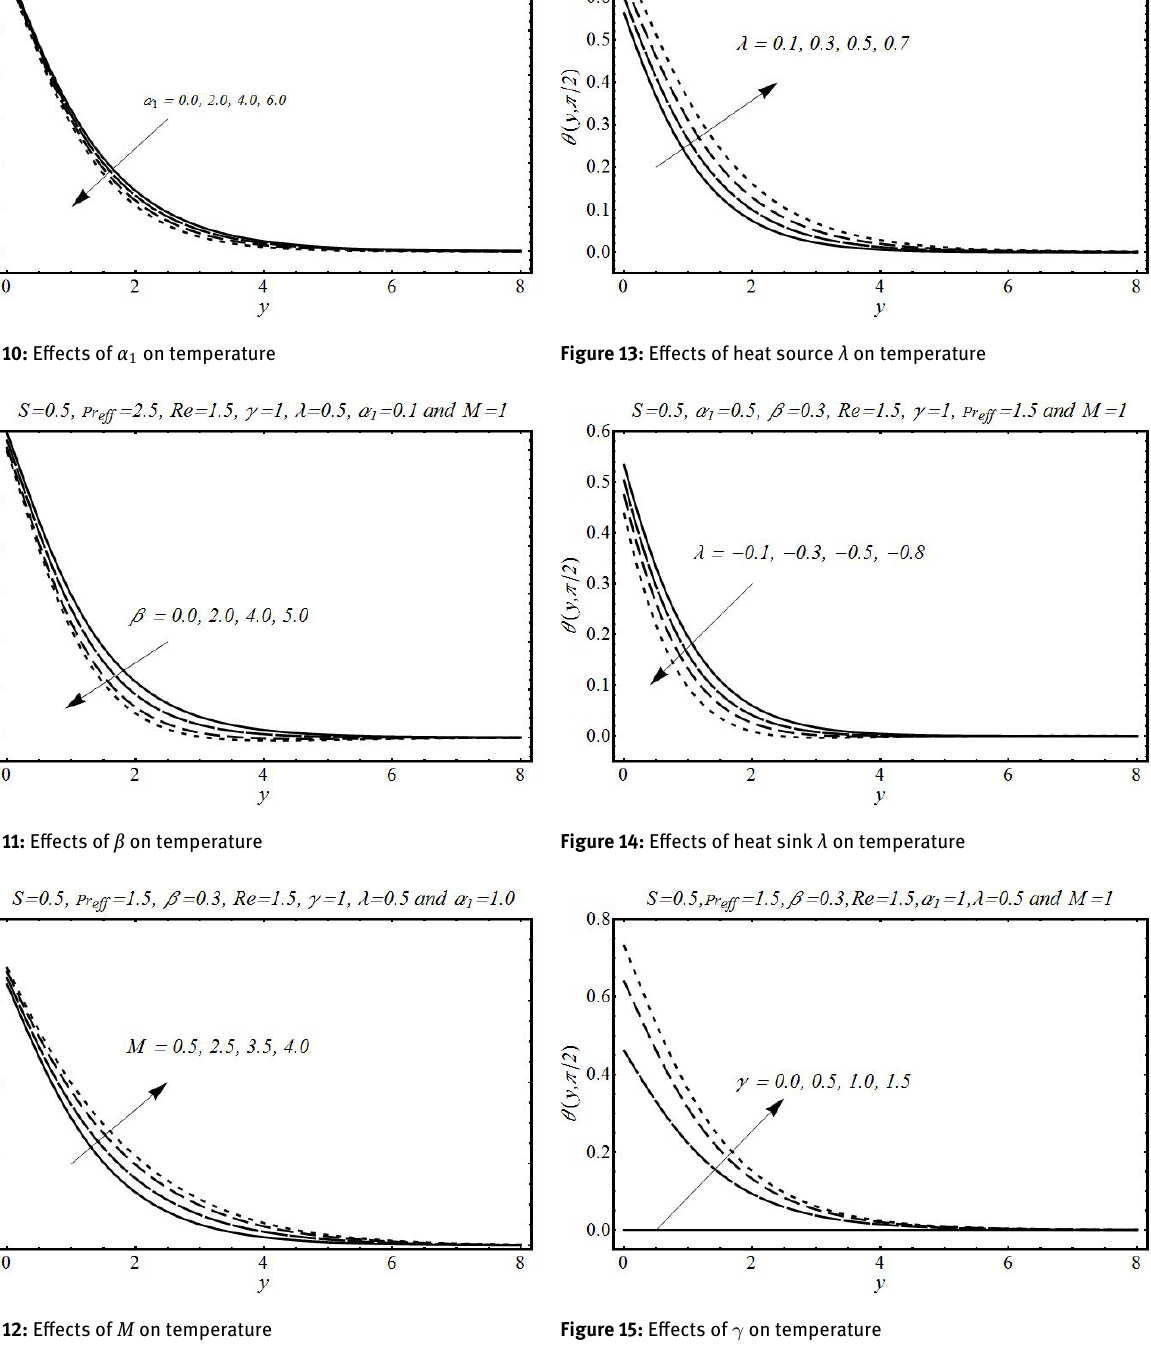
Figure 15: Effects of 𝛾 on